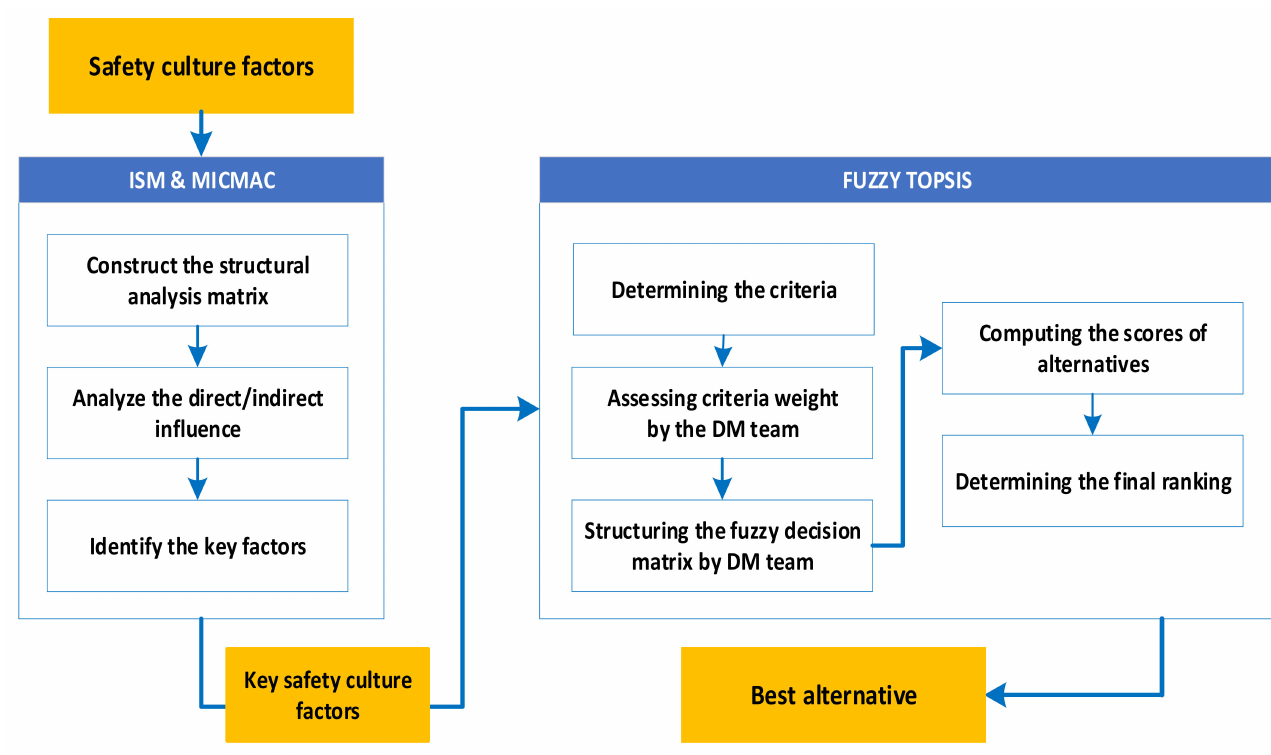
Figure 1. The model of the